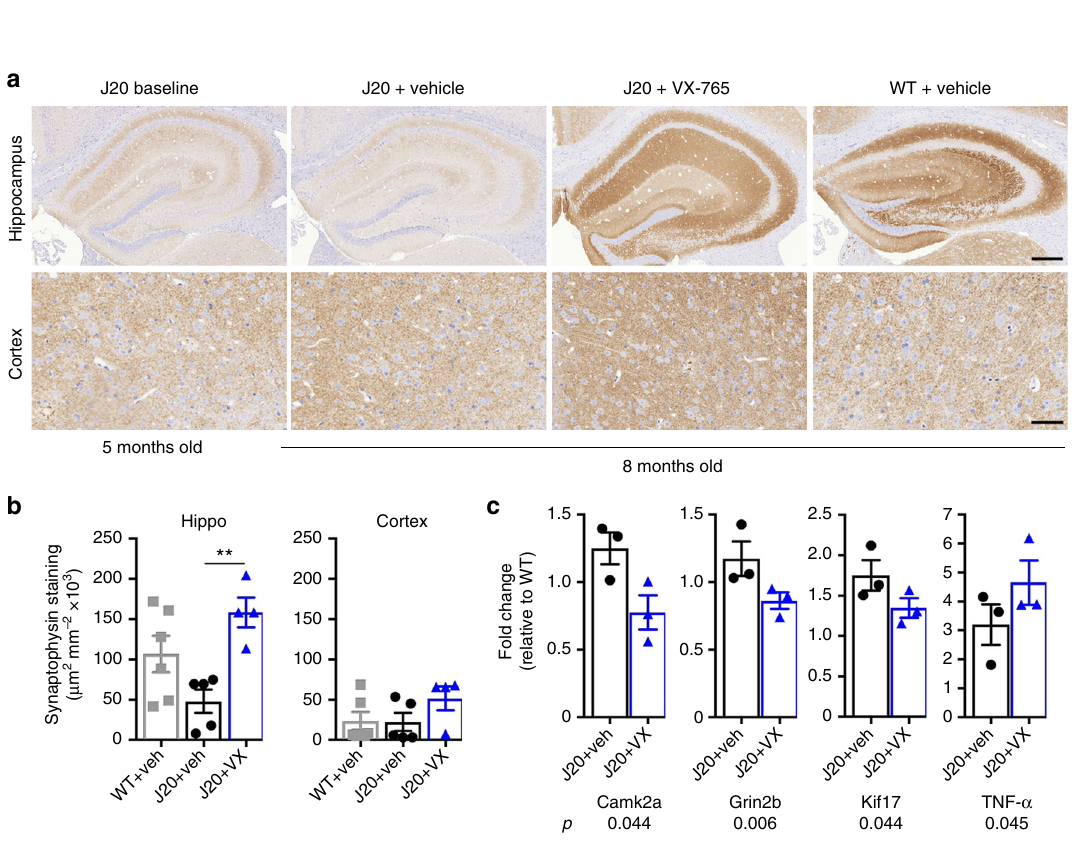
Fig. 6 VX-765 reverses loss of synaptophysin in J20 mice. a Synaptophysin immunopositive micrographs. Scale bar = 200 µ m for hippocampus and 50 µ m for cortex. b Synaptophysin immunopositive density in WT + vehicle (grey squares, n = 4), J20 + vehicle (black circles, n = 4), and J20 + VX-765 (blue triangles, n = 4) hippocampus (F(2,9) = 7.974, p = 0.0102, ANOVA, Tukey ’ s post-hoc, ** p < 0.01) and cortex. c Signi fi cantly altered (Kruskall − Wallis) synaptic protein mRNA levels in vehicle or VX-765-treated J20 mice hippocampi ( n = 3 per